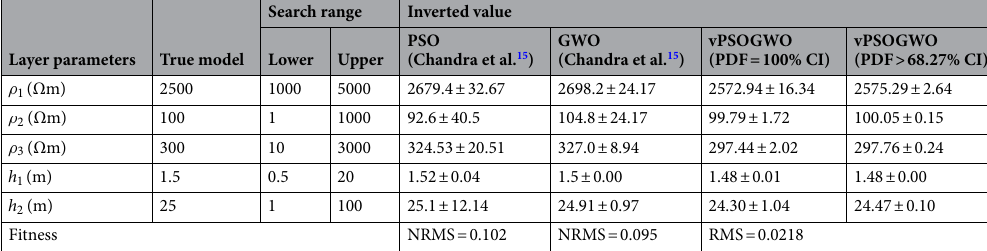
Table 1. Mean model with the level of uncertainty in the posterior utilizing individual inversion of DC synthetic data distorted with 10% noise from vPSOGWO, compared with results inverted by Chandra et al. 15 .